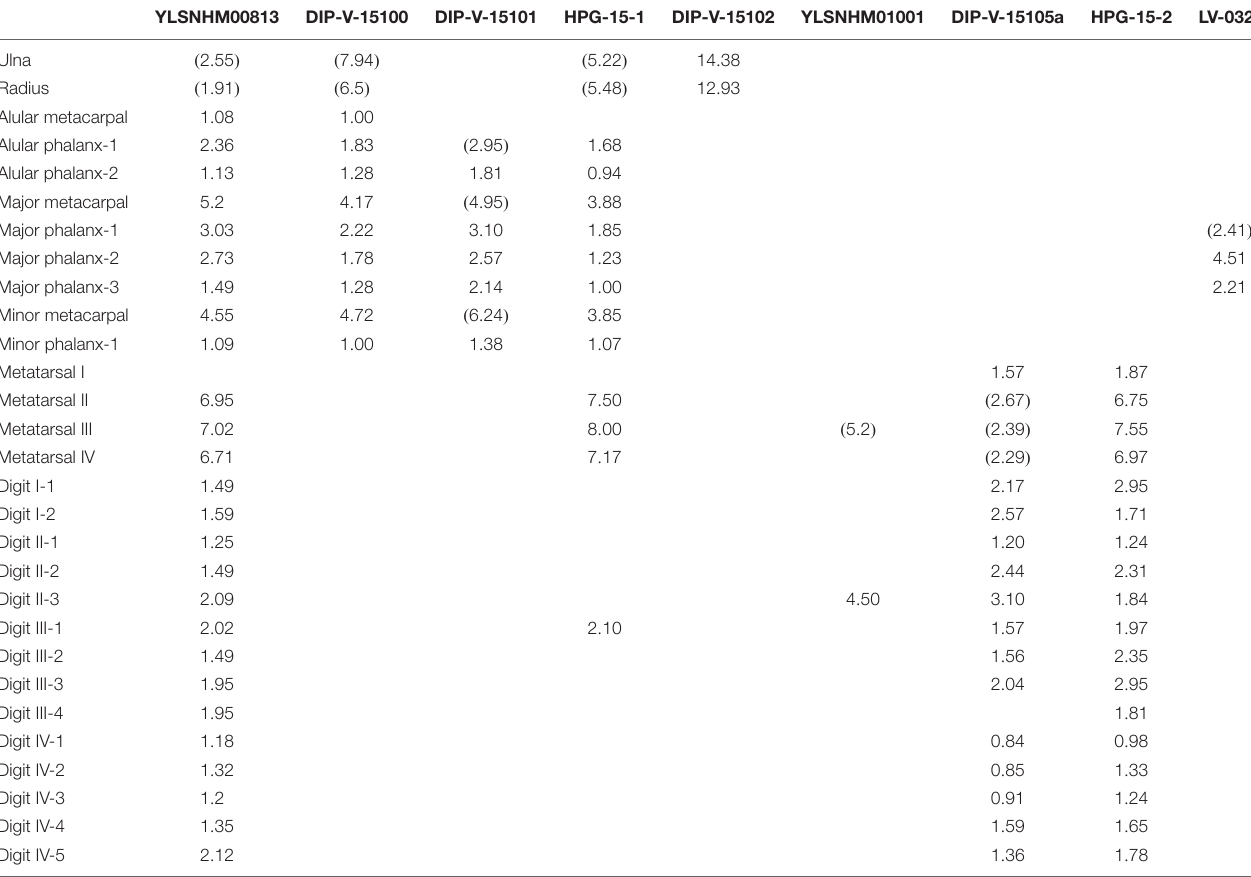
TABLE 1 | Comparative measurements of enantiornithines from the Hukawng avifauna.